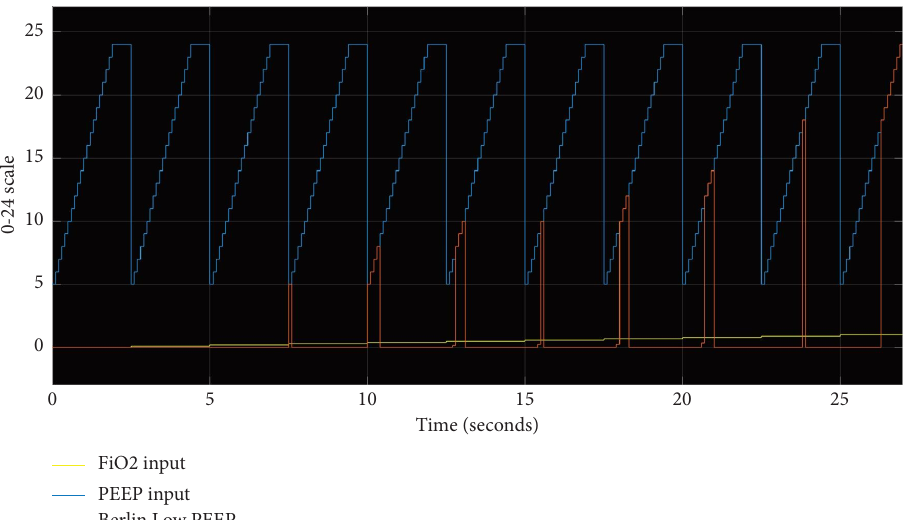
Figure 16: Graph showing the relationship between the two input parameters: FiO (blue in colour), with the fuzzifed Berlin low PEEP output (red in colour).